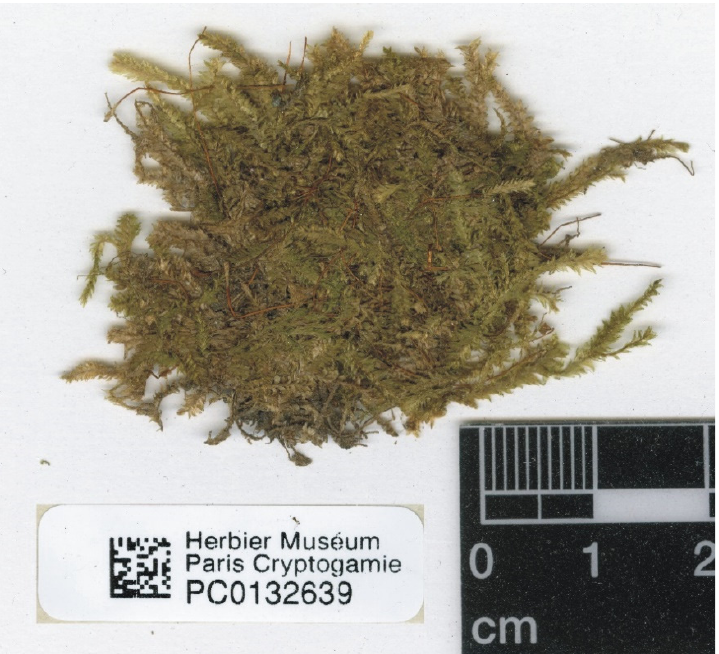
Figure 13. Turf of P . denticulatum var. auritum (specimen PC0132639). From the herbarium PC website (https://science.mnhn.fr), downloaded 15 April 2022.